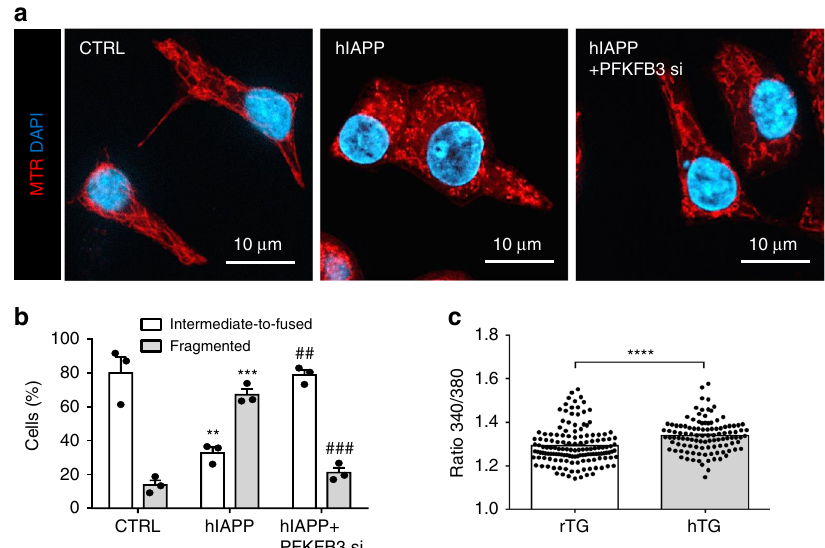
Fig. 7 PFKFB3 silencing restores the mitochondrial network in hIAPP toxicity. a Representative immuno fl uorescence images of INS 832/13 stained with Mitotracker red (MTR) (mitochondria, red), and DAPI (nuclei, blue). Cells were serum-starved for 56 h and transduced with adenoviral vectors expressing LacZ or hIAPP, silenced or not for PFKFB3 for 36 h. b Quanti fi cation of mitochondrial morphology in serum-starved INS 832/13 cells after indicated treatments to overt intermediate-to-fused or overt fragmented. c Cytosolic calcium concentration measured in isolated islets from rodent IAPP (rTG) and human IAPP (hTG) transgenic mice. Data are presented as mean ± SEM, n = 3 independent experiments for each group. Statistical signi fi cance was analyzed by Student t -test (* p < 0.05, ** p < 0.01, *** p <